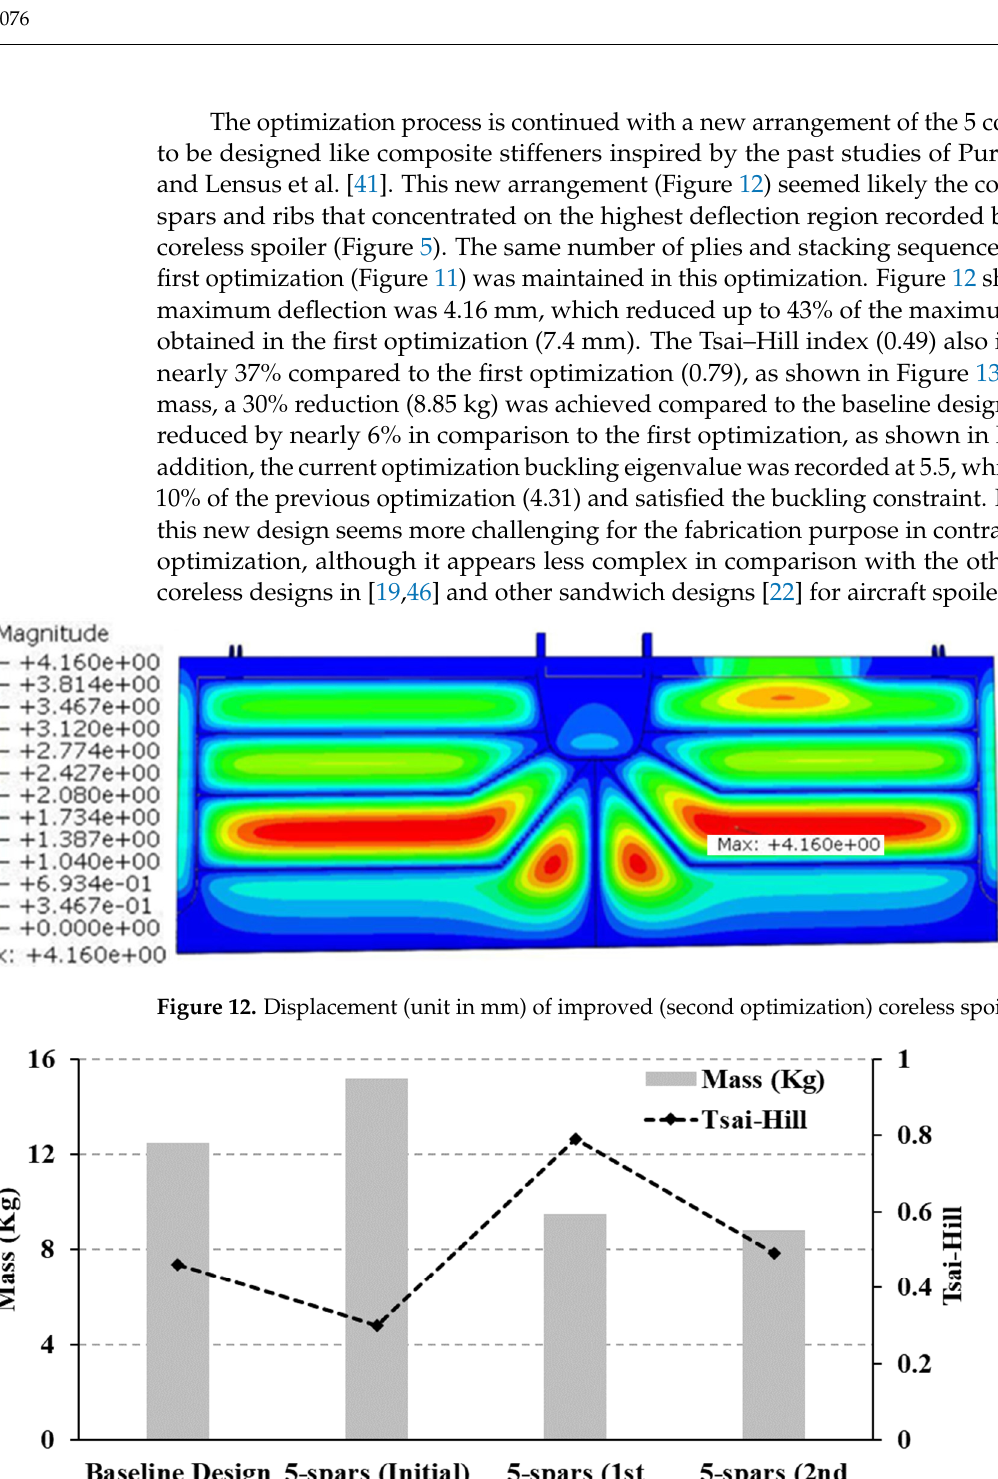
Figure 11. Tsai–Hill of improved (first optimization) 5-co-cured-spar coreless spoiler (upper skin removed).